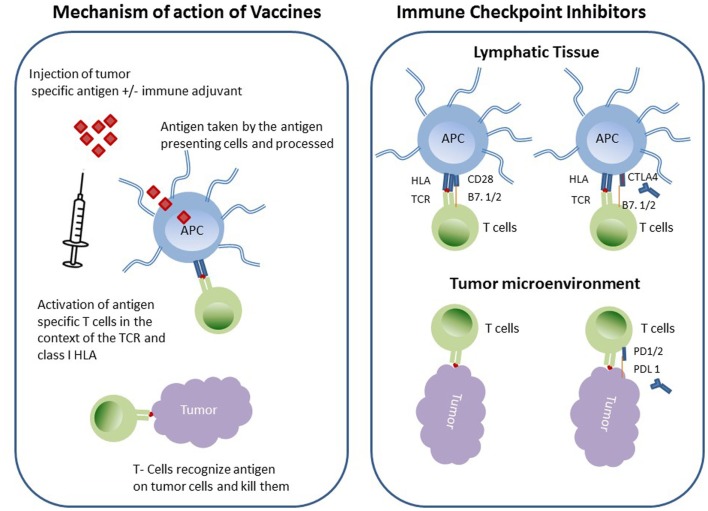
Schematic diagram of immunotherapeutic strategies in NSCLC.